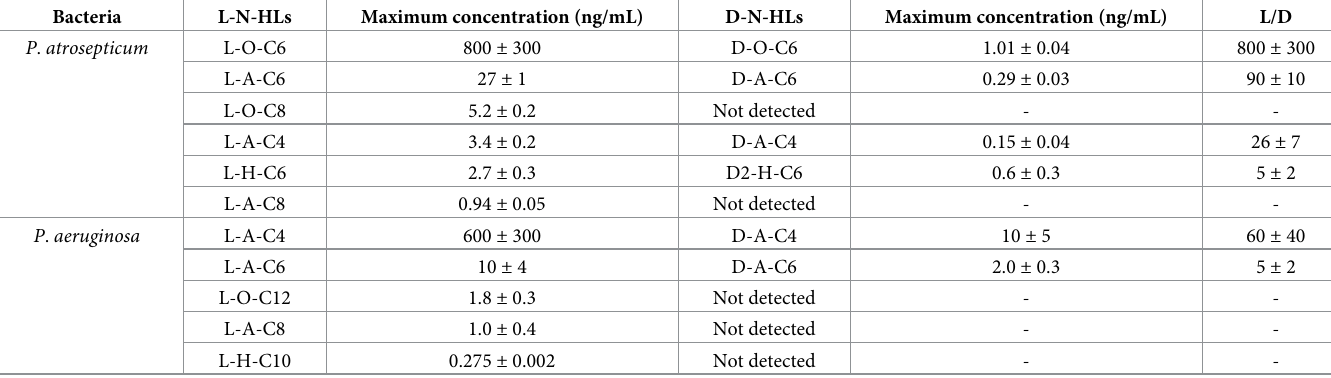
Table 2. Maximum concentrations of each N-HL produced during the growth period quantified using LC-MS/MS.